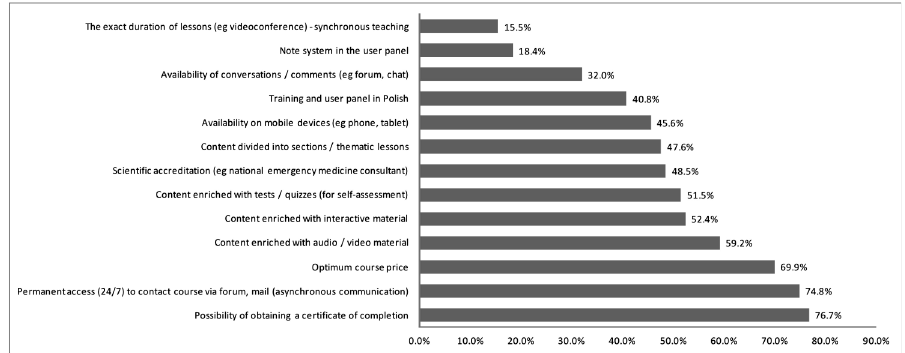
Figure 5. Conditions that should be fulfilled to call an e-learning course an effective one (number of respondents in %)